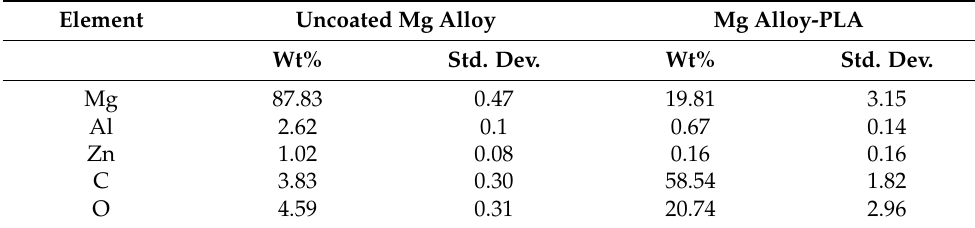
Figure 2. SEM micrographs of ( a ) uncoated Mg alloy, and ( b ) Mg alloy coated with PLA nanofibers at 1k and 10k magnifications, respectively. Table 2. Elemental composition in wt% (obtained by EDX) of the uncoated and coated Mg alloy.